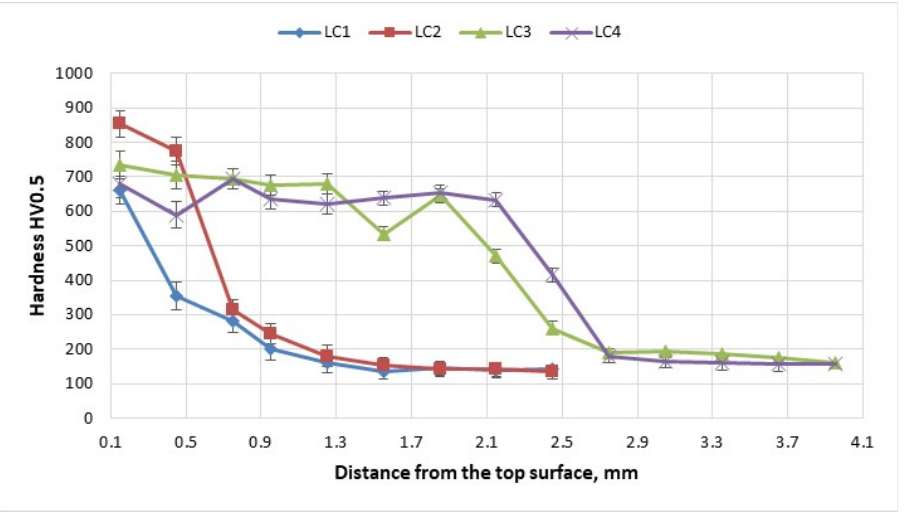
Figure 12. Hardness distribution on cross ‐ sections of the representative clad layers produced by laser cladding of experimental composite NiCrBSi/WC + W 2 C powder with different processing parameters (Table 2).